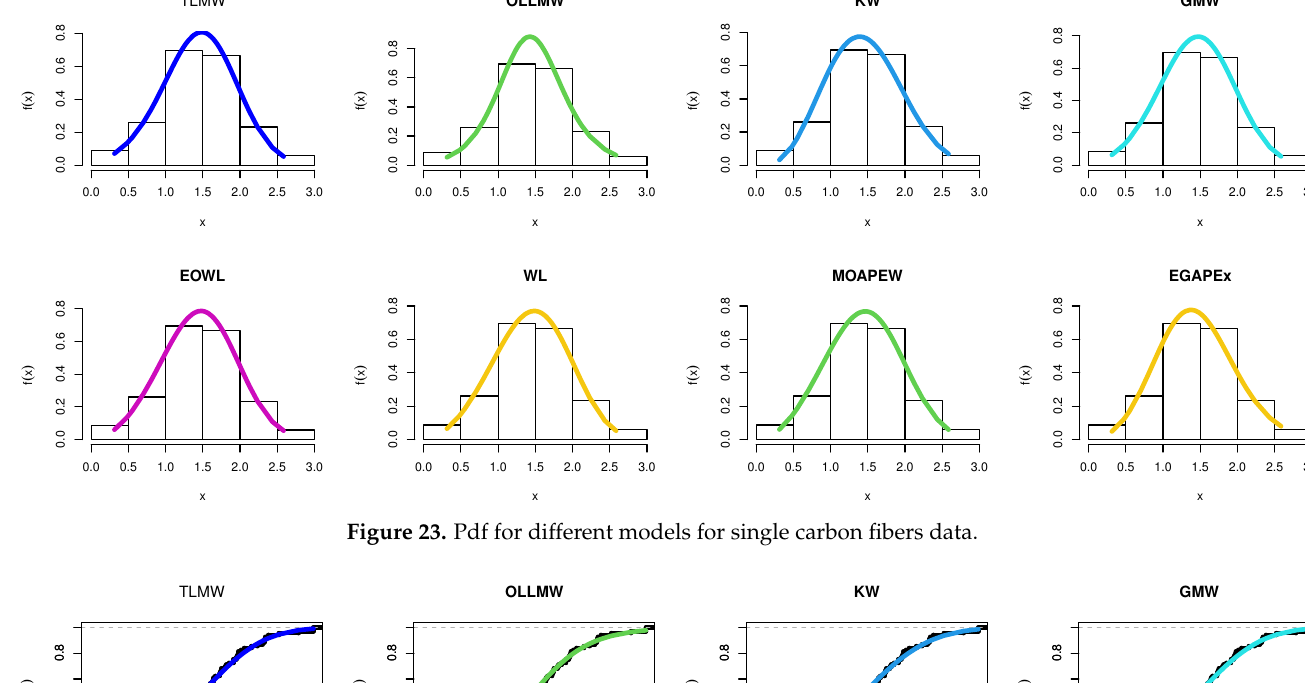
Figure 23. Pdf for different models for single carbon fibers data.